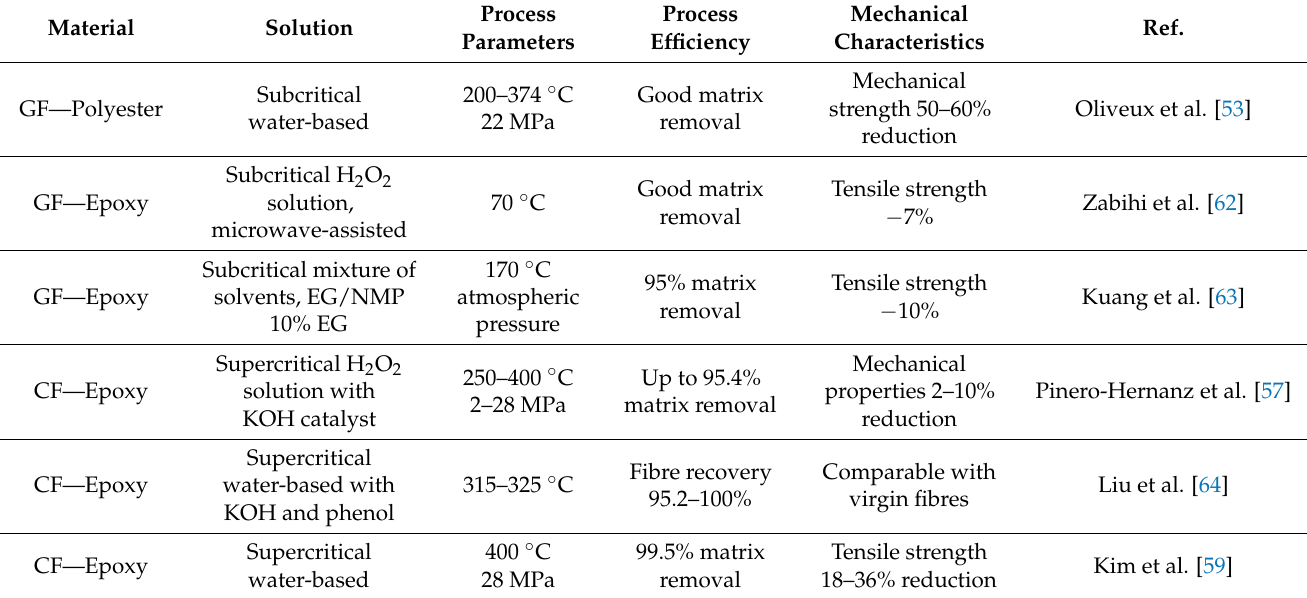
Table 1. Main results deriving from the solvolysis using supercritical and subcritical